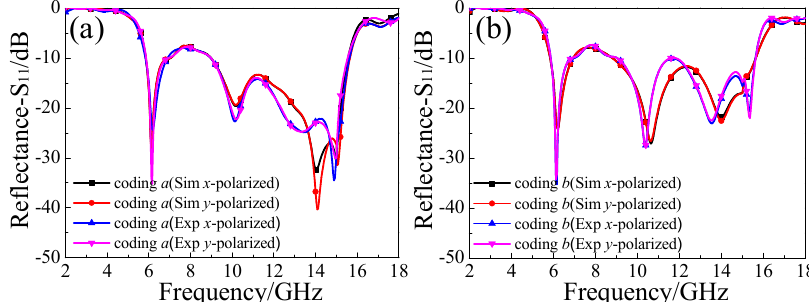
Figure 8. The simulated and measured reflectances of the MS samples at x - and y -polarized wave incidence: ( a ) coding a ; and ( b ) coding b .